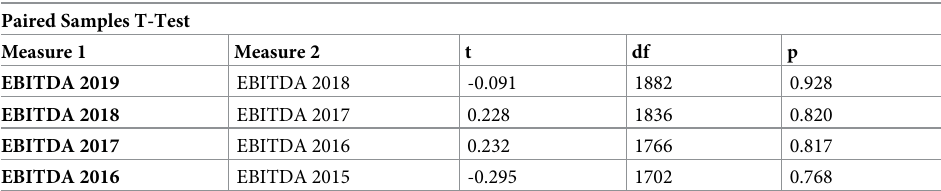
Table 5. Paired samples T-Test of EBITDA. Paired Samples T-Test